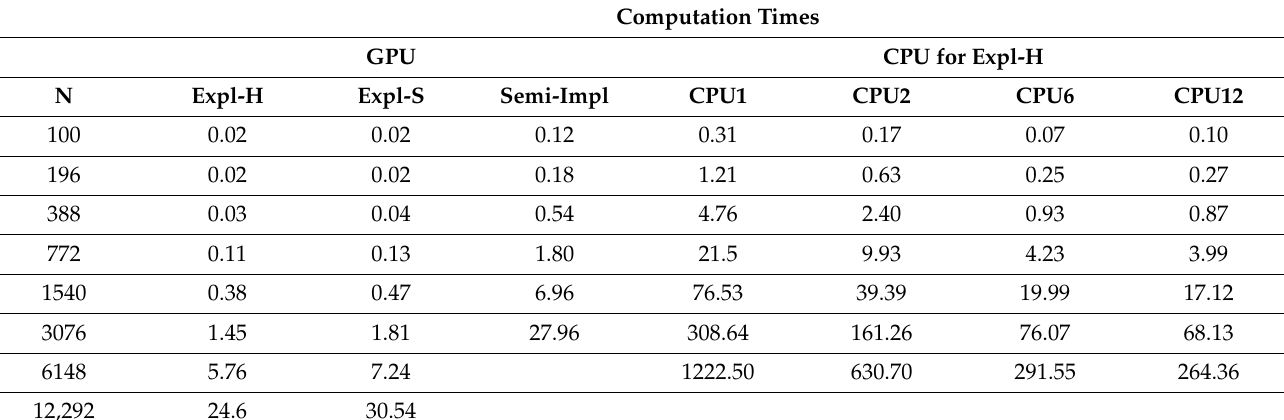
Table 1. Table of computation time of 1000 time steps in seconds for di ff erent grid sizes. The CPU rows are the computation times for the C++ CPU implementation for various cores.